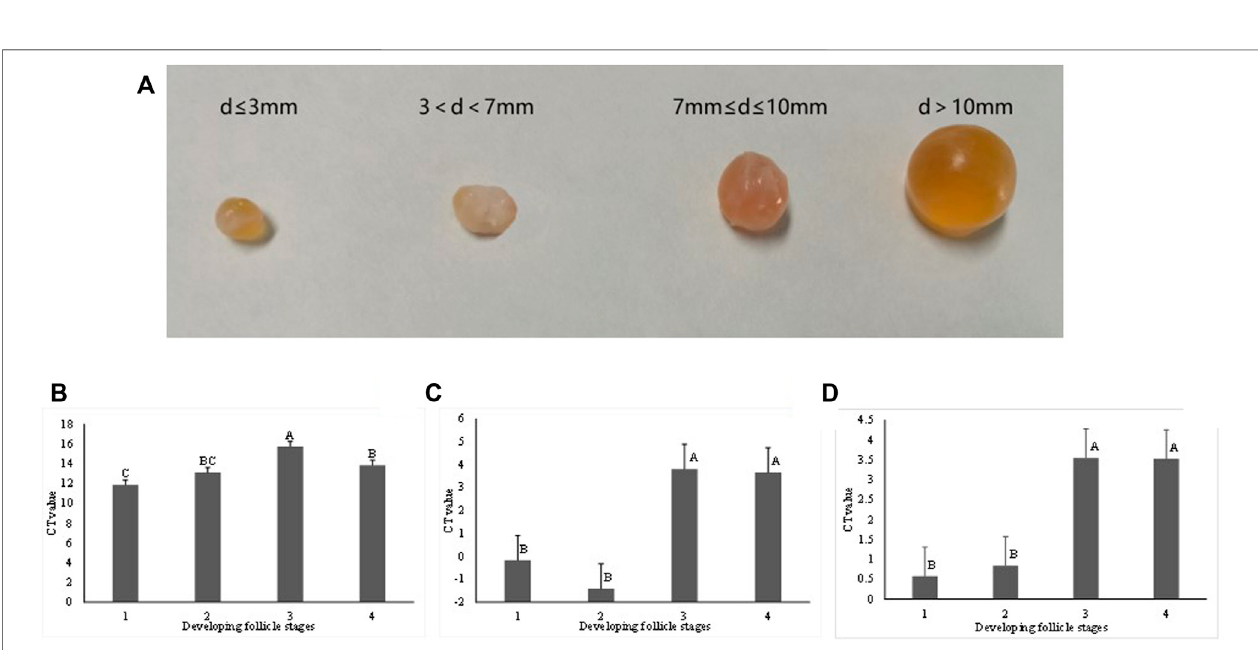
FIGURE 4 | The bovine follicles at different developmental stages (A) , and the relative mRNA expression level of the gene CACNB2 (B) , SLC39A12 (C) and ZEB1 (D) inisolatedgranulosa.Basedonthediameter (D) ,folliclesweredividedintofourstages,includingstage1(d ≤ 3 mm),stage2(3 mm < d ≤ 7 mm),stage3(7 mm < d ≤ 10 mm) and stage 4 (d > 10 mm). Different letters are used when the expression levels are signi fi cantly different between two stages ( p < 0.05).